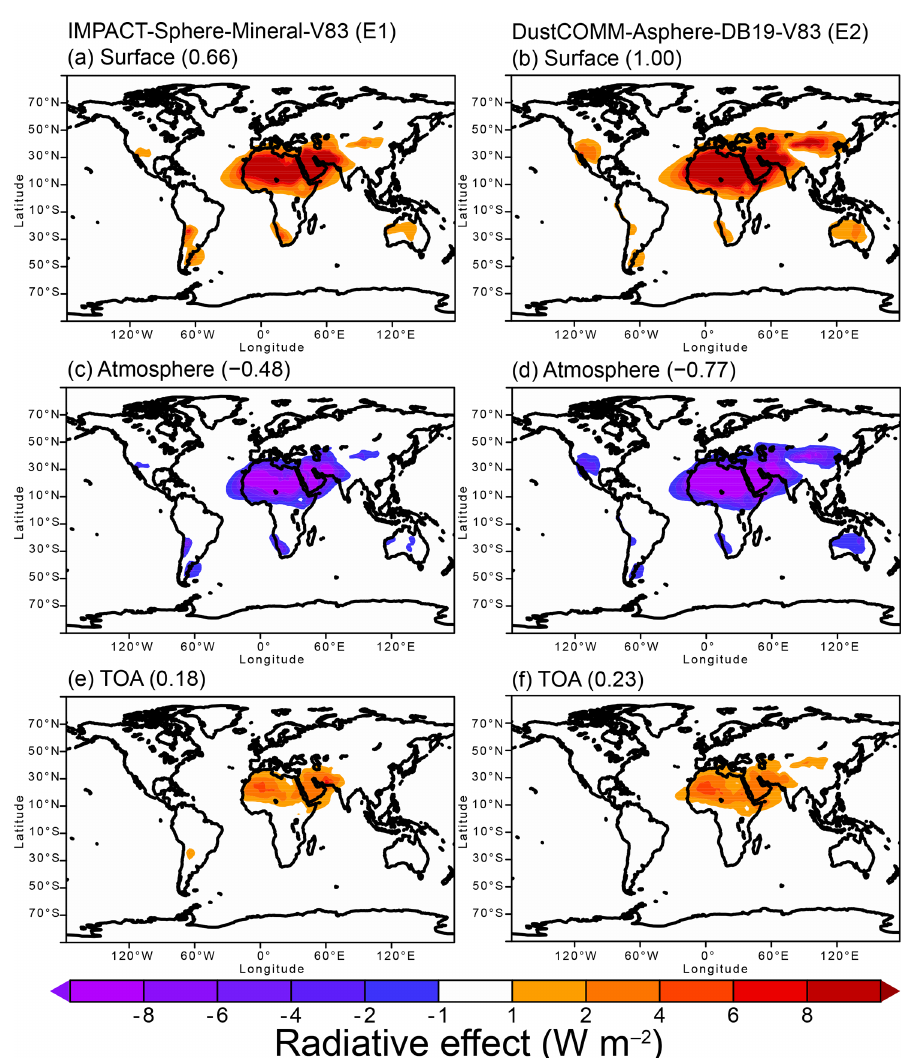
Figure 7. Dust LW radiative effect (Wm − 2 ) and radiative heating of the atmosphere (i.e., the subtraction of radiative effects from TOA to the surface in units of Wm − 2 ). The model results are shown for the simulations for (a) IMPACT-Sphere-Mineral-V83 (E1) at the surface, (b) DustCOMM-Asphere-DB19-V83 (E2) at the surface, (c) E1 in atmospheric column, (d) E2 in atmospheric column, (e) E1 at TOA, and (f) E2 simulations at TOA. The numbers in parentheses represent the global